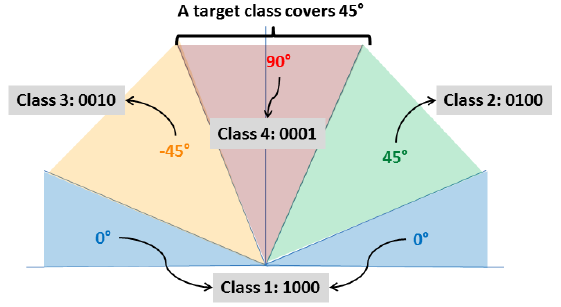
Figure 5. How recognition classes are divided. Each class covers a range of 45 ◦ . Adapted from [17].